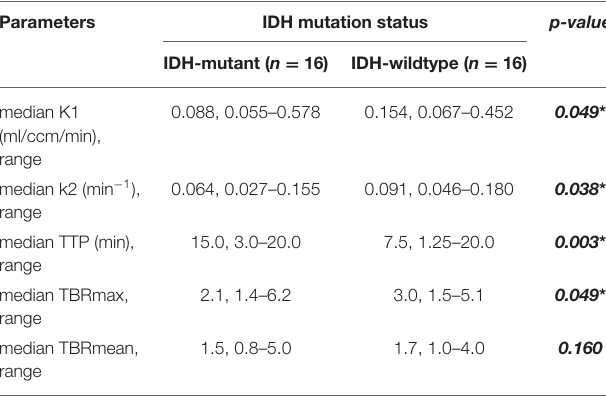
TABLE 4 | Comparison of imaging parameters and IDH mutation status of each biopsy site.